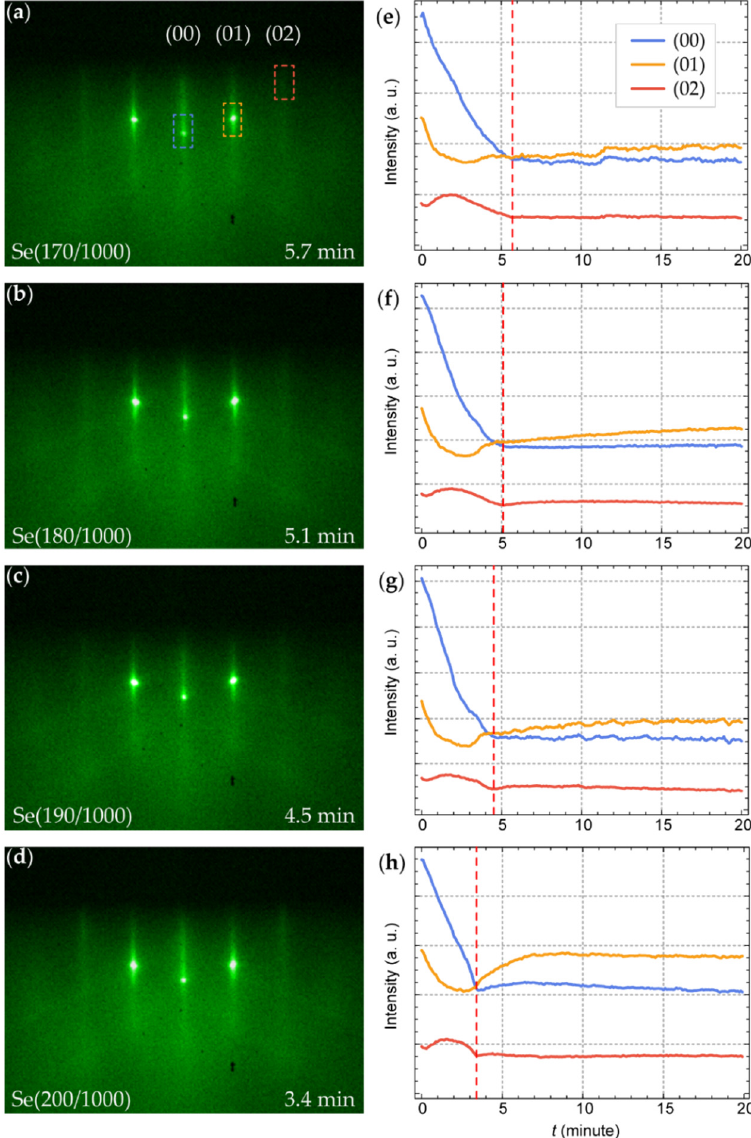
Figure 3. RHEED characterization on the growth of FeSe for different Se fluxes. ( a – d ) RHEED images of monolayer FeSe grown with various Se flux as labeled on the figures. ( e – h ) Real-time RHEED intensity of (00), (01), and (02) diffractions during growth, corresponding to the samples in ( a – d ). The integrated areas are marked on ( a ) and are the same for ( b – d ). The red dashed lines in ( e – h ) indicate the time at which the first layer FeSe is